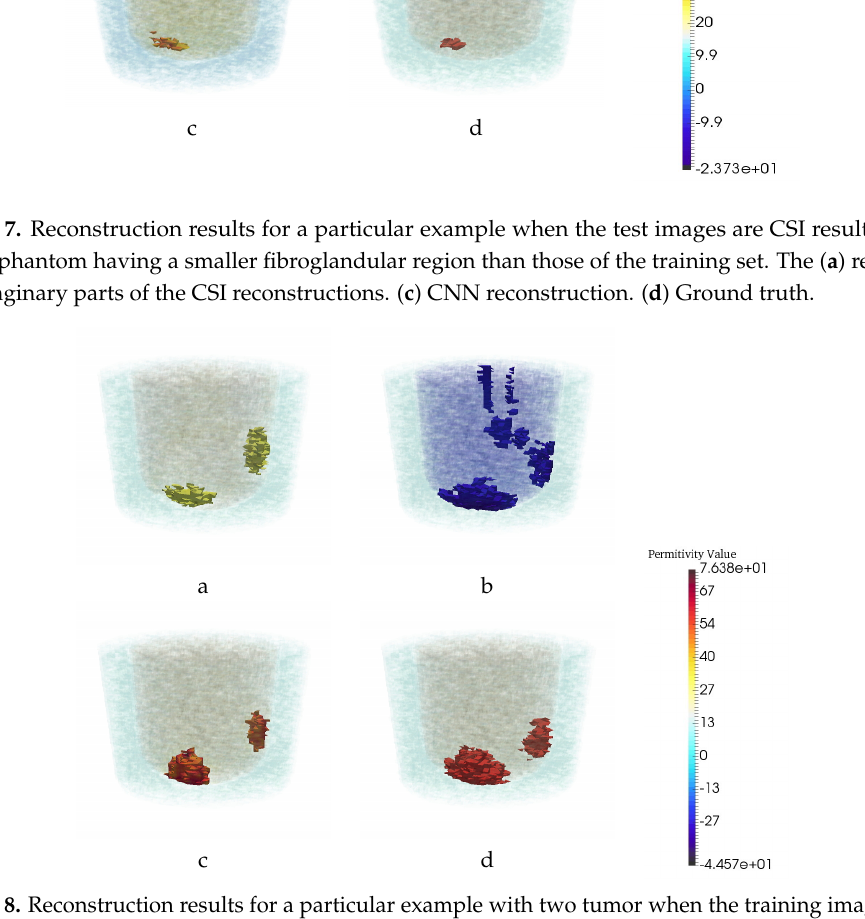
Figure 8. Reconstruction results for a particular example with two tumor when the training images are CSI results with perfect prior information, but the neural net was tested on imperfect prior information. The real ( a ) and imaginary ( b ) part of CSI reconstruction. ( c ) CNN reconstruction. ( d ) Ground